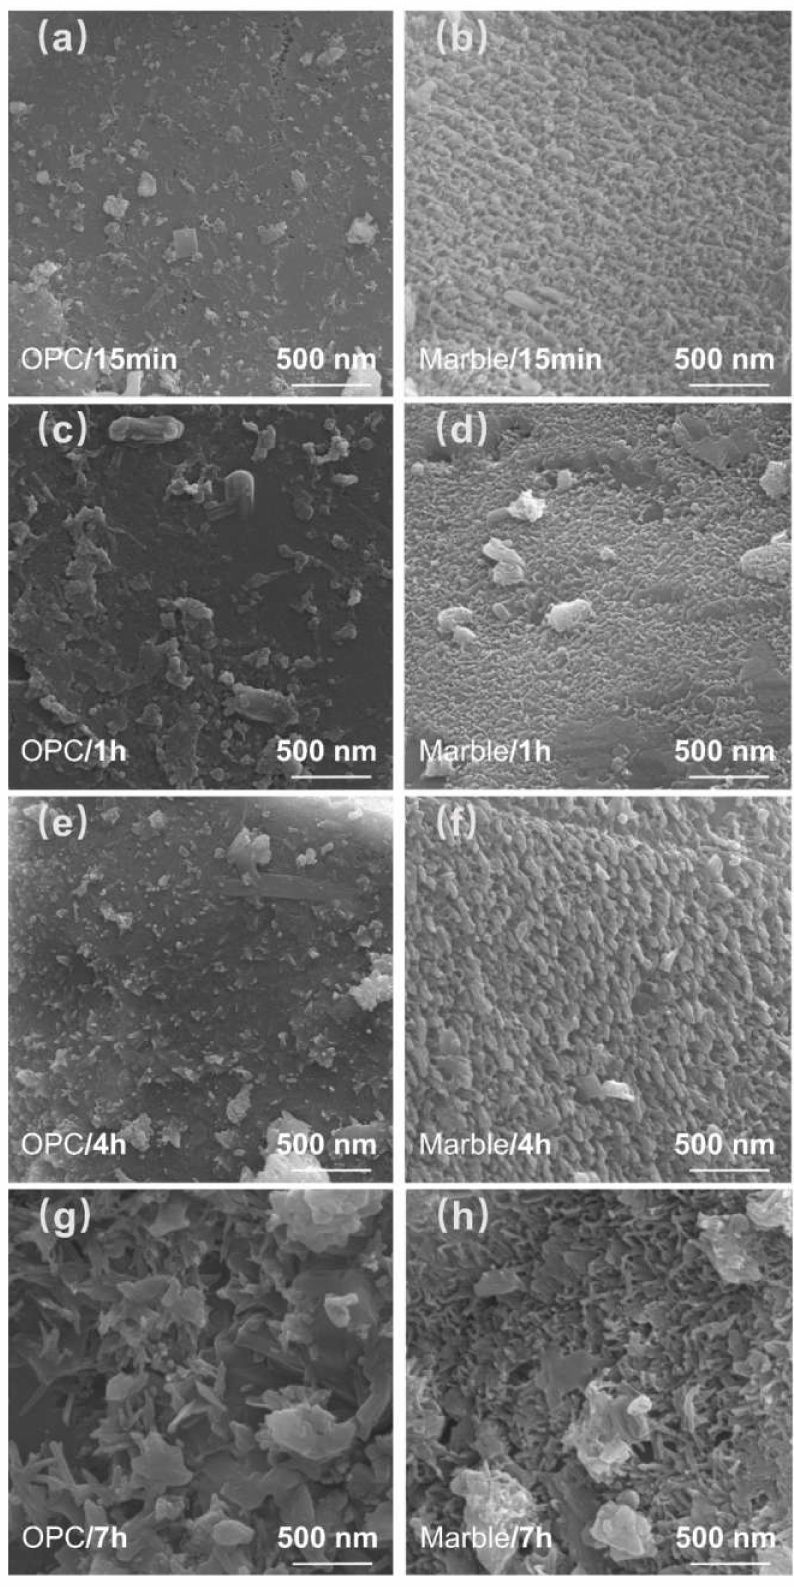
Figure 6. Morphology of hydrates on the surface of cement (OPC) particle at 15 min ( a ), 1 h ( c ), 4 h ( e ), and 7 h ( g ) and marble particle at 15 min ( b ), 1 h ( d ), 4 h ( f ), and 7 h ( h